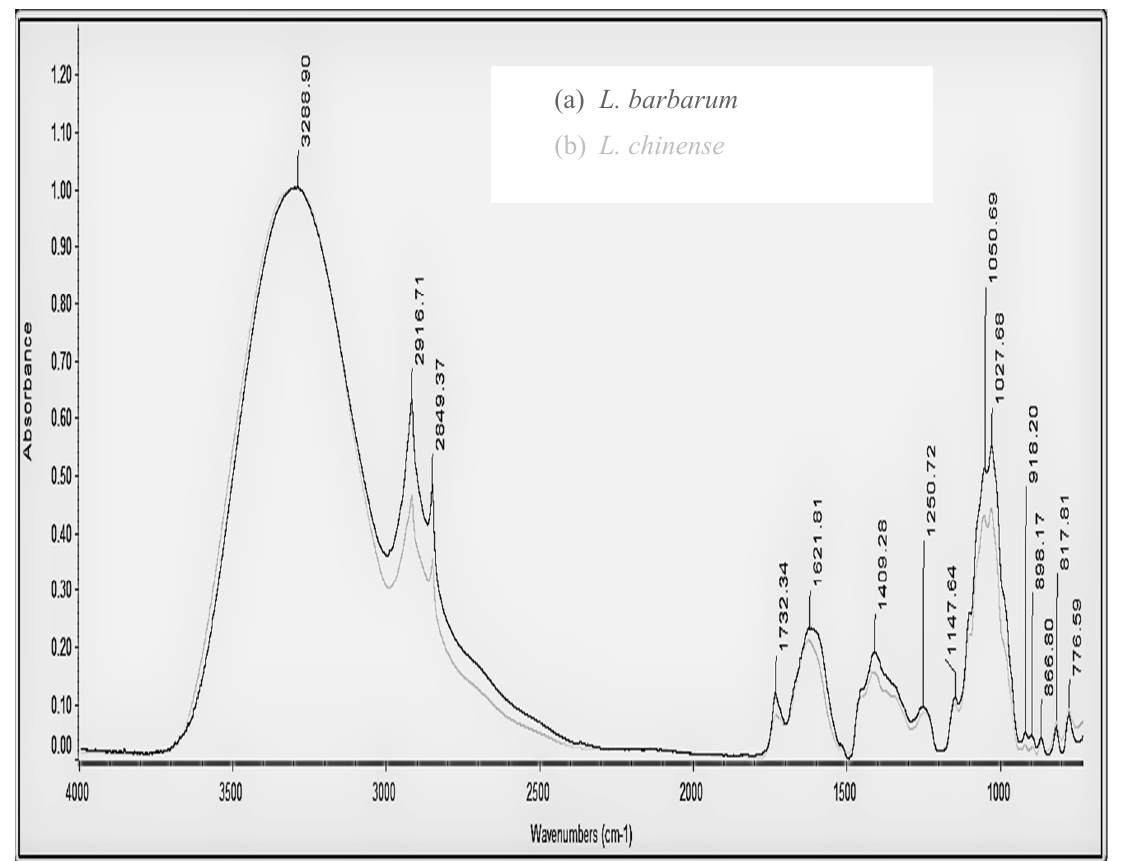
Figure 1. Typical attenuated total reflection Fourier-transform infrared (ATR-FT-IR) spectra of Lycium barbarum L. (a) and L. chinense Mill. (b) fruits cultivated in central Greece.